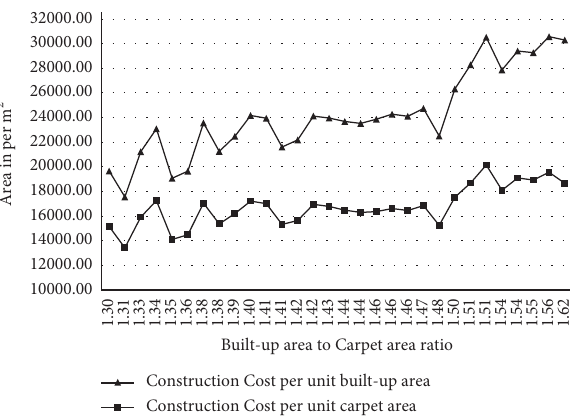
Figure 4: Variation in construction cost with respect to built-up-to-carpet area